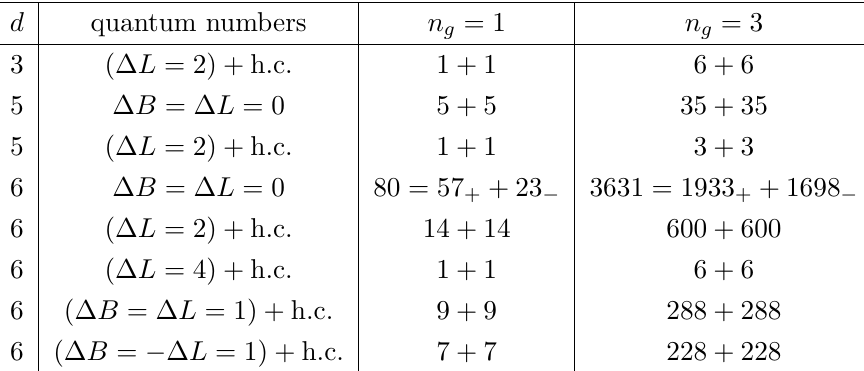
which contains QCD gauge interactions of n u = 2 u -type quarks and n d = 3 d -type quarks and QED gauge interactions of the u quarks, d quarks, and n e = 3 charged leptons at dimension four, and Dirac-fermion mass terms for u , d , and e at dimension three. The n ν = 3 left-handed neutrinos are gauge singlets with no mass term. Theta terms for QCD and QED are included as